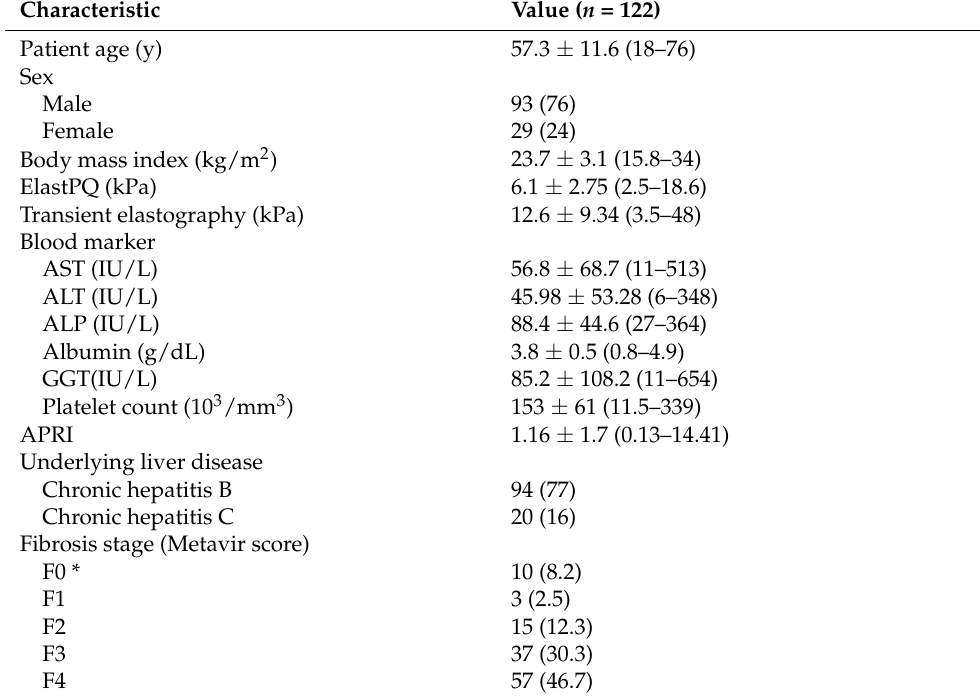
Table 1. Patient demographics and clinical features.